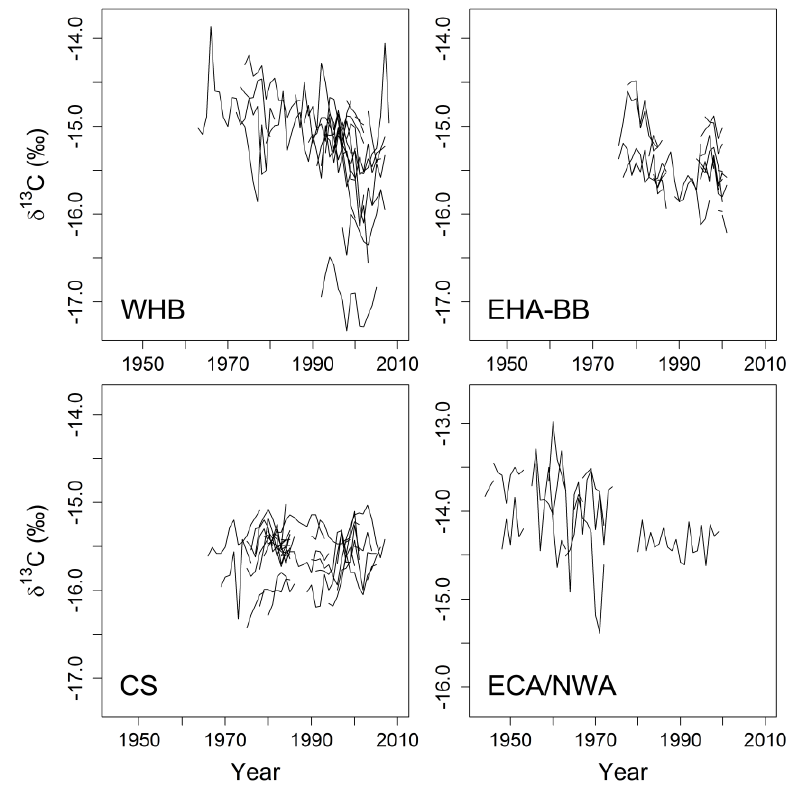
Fig. 2. Significant  13 C declines across dentinal GLGs of –0.0186 ± 0.00602 ‰ yr -1 and –0.0285 ± 0.00458 ‰ yr -1 in both the Western Hudson Bay (WHB) and Eastern High Arctic–Baffin Bay (EHA–BB) beluga populations, respectively, were statistically indistinguishable from  13 C declines across dentinal GLGs of Eastern Canadian Arctic/Northwest Atlantic killer whales (–0.0184 ± 0.00540 ‰ yr -1 ; ECA/NWA) over a similar timeframe when rates were based on annual GLG deposition in beluga whales. In contrast,  13 C values in the Cumberland Sound (CS) population were relatively constant over the same